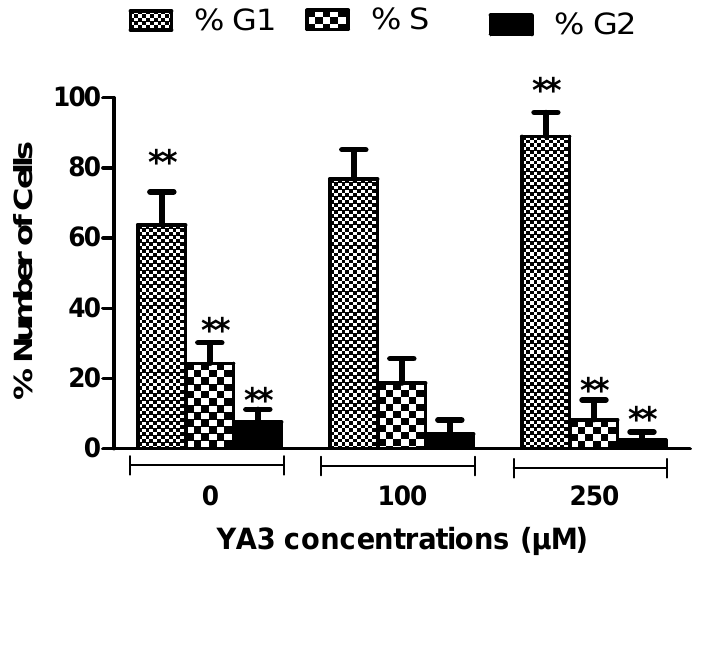
Figure 7. Cell cycle analysis of U937 cell lines treated with various concentrations of YA3 for 24h. Results are expressed as percentage of cells in G1, S, and G2/M phases of the cell cycle. The results of all treatments experiments were compared to control. The results for each time point represent the mean ± standard deviation of three separate experiments (* P < 0.05, ** P < 0.01, *** P < 0.001). All comparisons were made using two-tailed student’s t